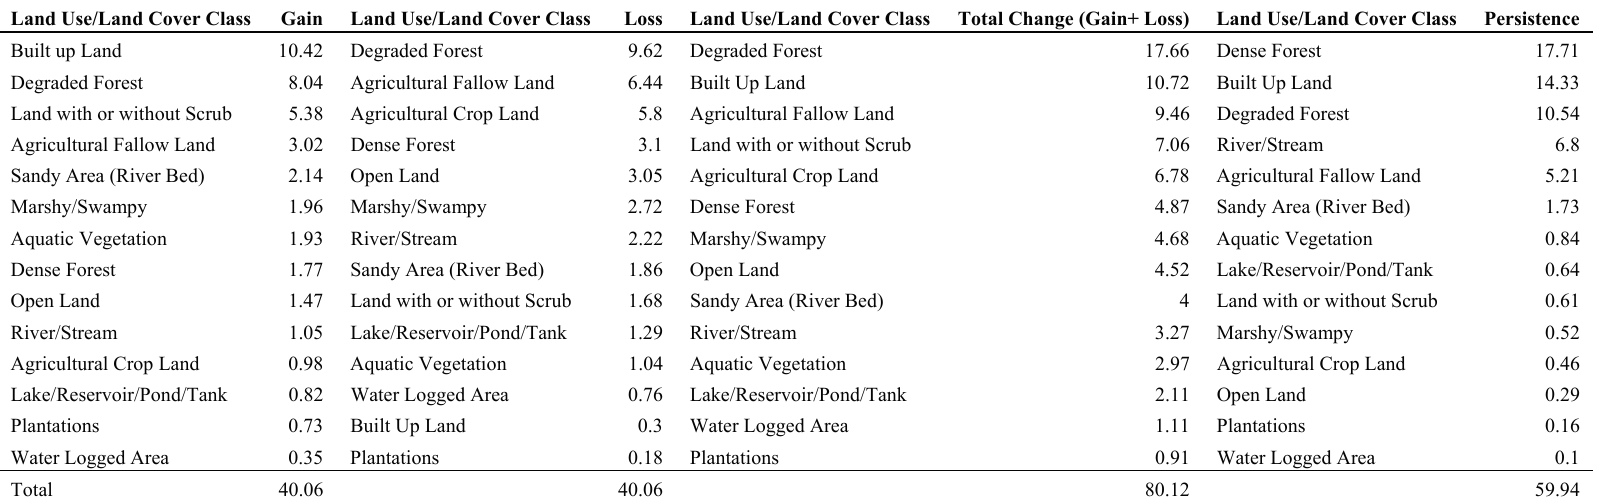
Table 11. Ranking, % of gains, losses and persistence’s of LULC category between 1987 and 1997.